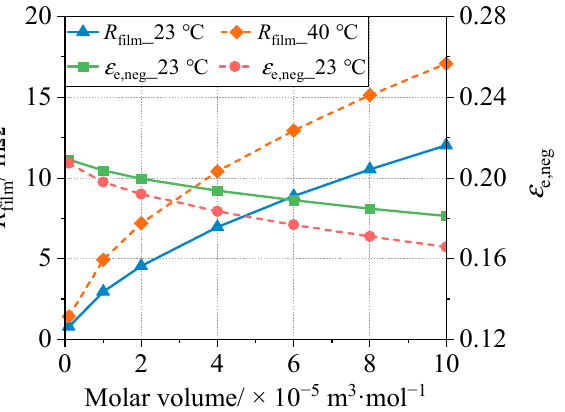
volume values in the range of 1 × 10 − 6 to 1 × 10 − 4 m 3 /mol had a substantial effect on the cell capacity’s decline and heat generation after aging. the cell capacity’s decline and heat generation after aging.